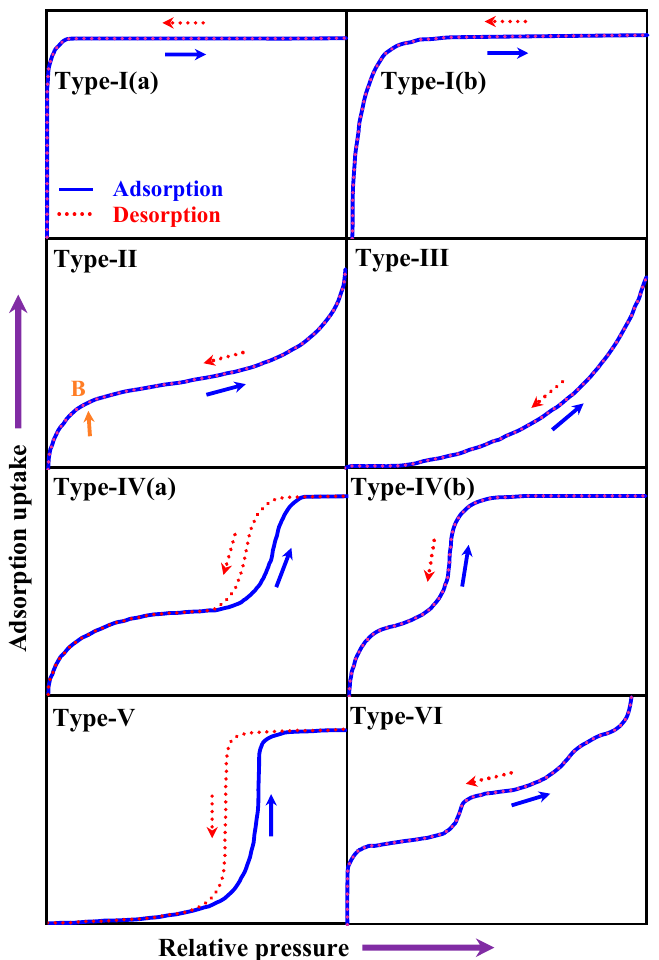
Figure 1. Types of adsorption isotherms [9,12]. (Reproduced with permission).